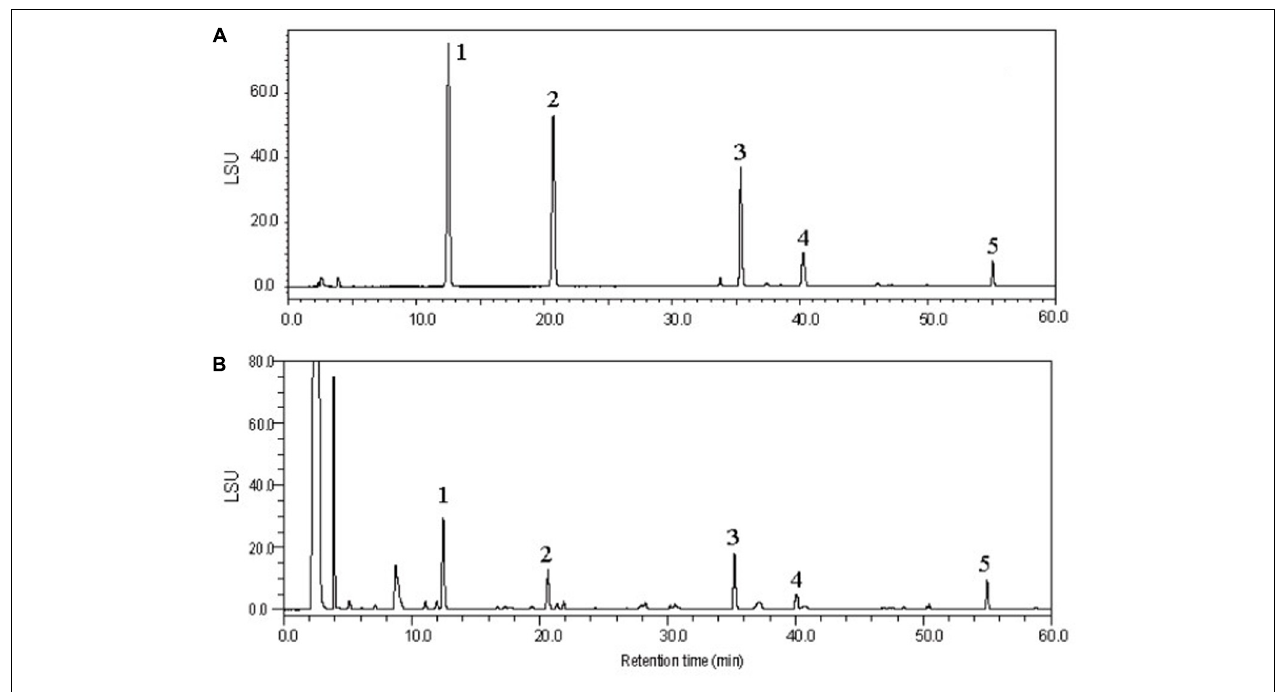
FIGURE 1 | High-performance liquid chromatography coupled with evaporative light scattering detection (HPLC-ELSD) chromatography of mixed standards (A) and sample (B) for flavonoids and triterpenoids analyzed in the present study. Spinosin (1), 6 (cid:48)(cid:48)(cid:48) -feruloylspinosin (2), jujuboside A (3), jujuboside B (4), and betulinic acid (5).